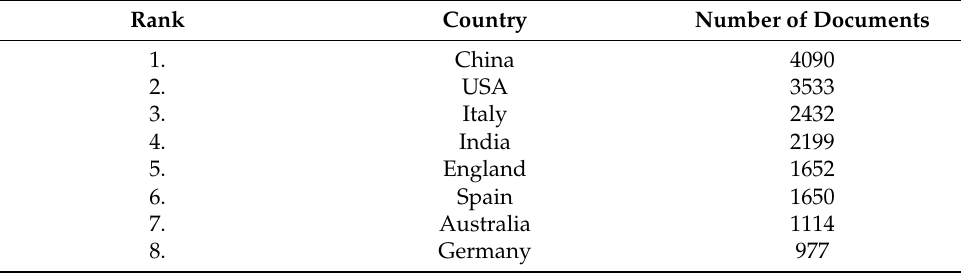
Table 2. Top eight countries dealing with the topic of Smart